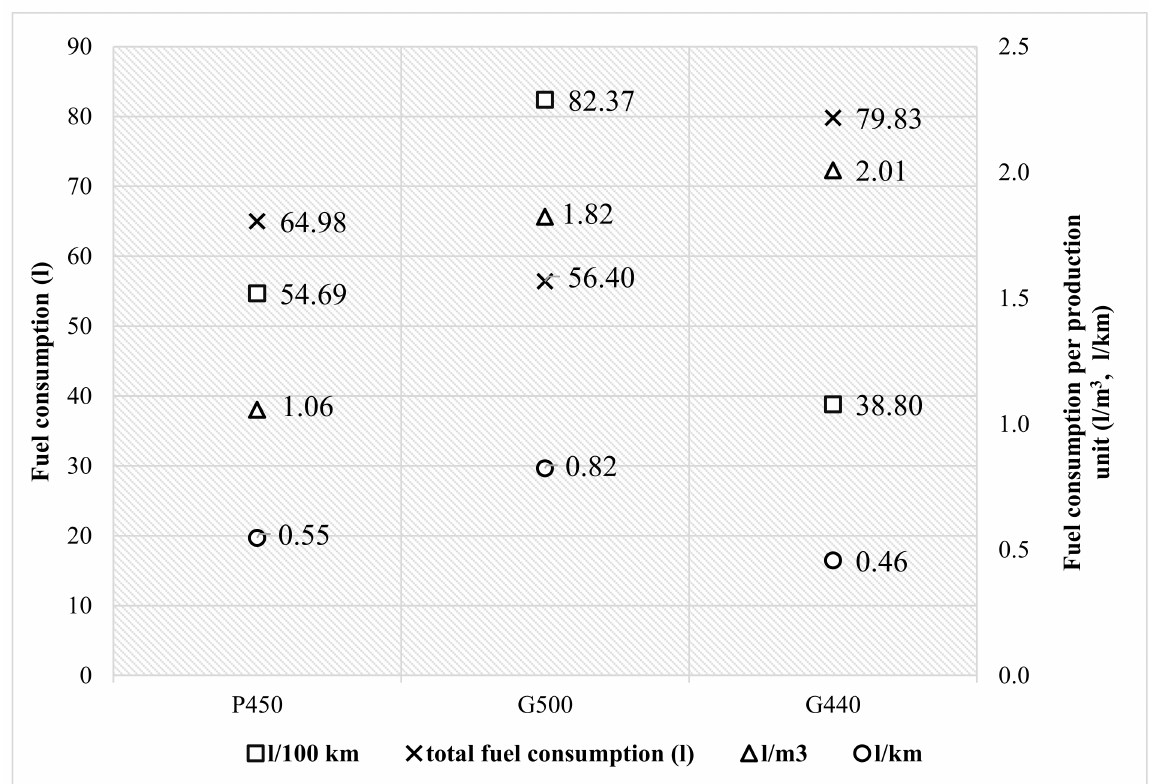
Figure 3. Fuel consumption per 100 km, total fuel consumption in L, fuel consumption per m 3 of hauled timber and per travel distance.